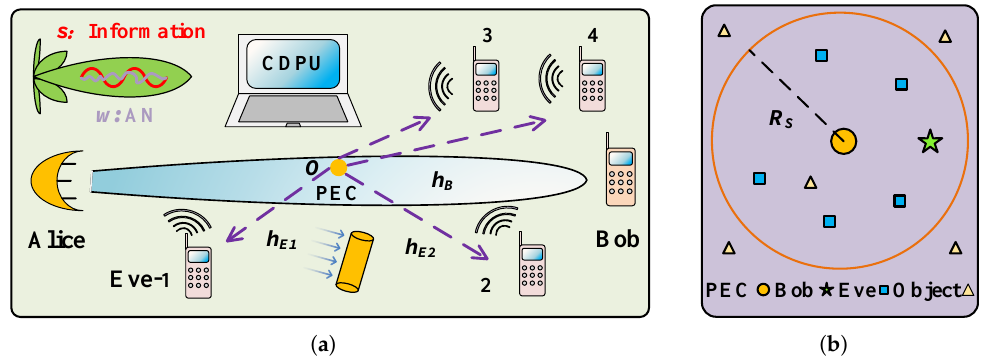
Figure 1. System model. ( a ) Alice transmits a highly directive THz signal x to Bob with or without AN w . A PEC (orange cylinder) located at the edge of beam can scatter the incident THz wave to Eves in all directions. ( b ) The spatial distribution of Eves is modeled as PPP in a circle region. The objects in this indoor scene can scatter THz